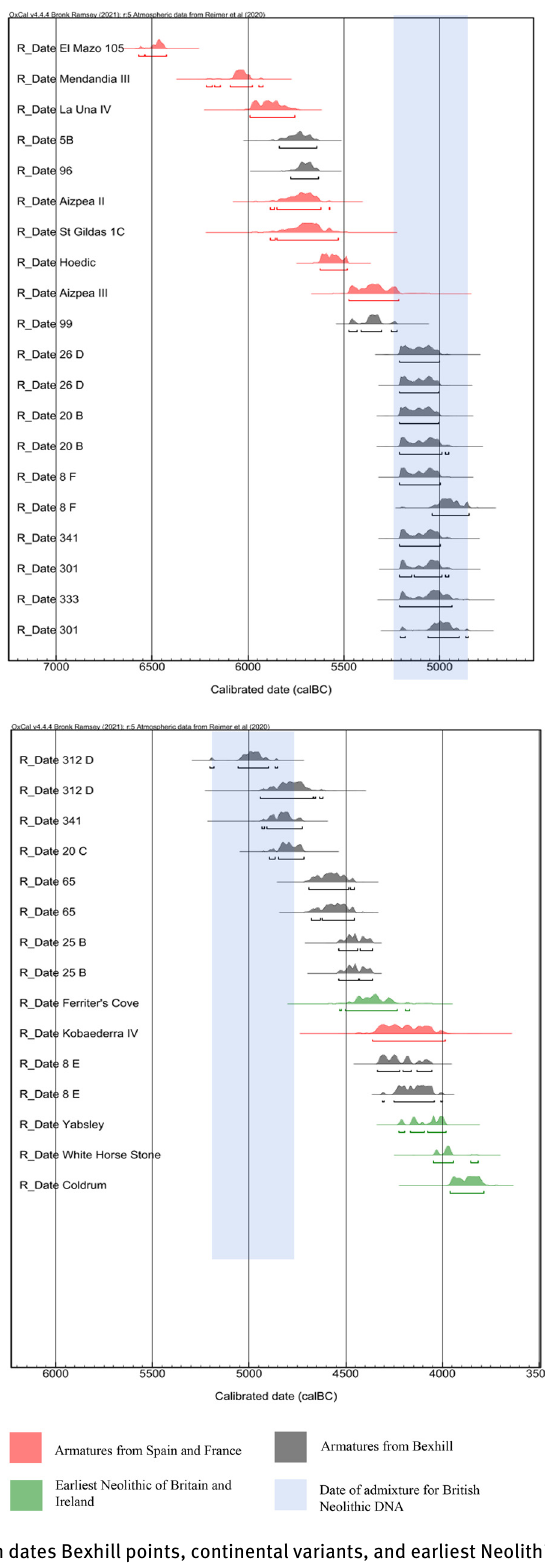
Figure 10: Selected radiocarbon dates Bexhill points, continental variants, and earliest Neolithic of Britain and Ireland. The date of admixture between hunter - gatherers and British farmers is also shown ( Alday, 2014; Alday & Cava, 2008; Campos et al., 2016; Cubas et al., 2016; Dupont et al., 2007; Marshall, 2019; Rivollat et al., 2020 )